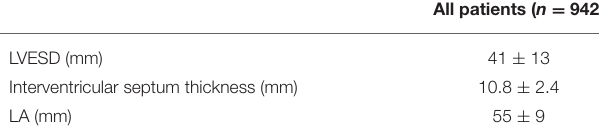
TABLE 1 | Demographic characteristics and clinical parameters of study